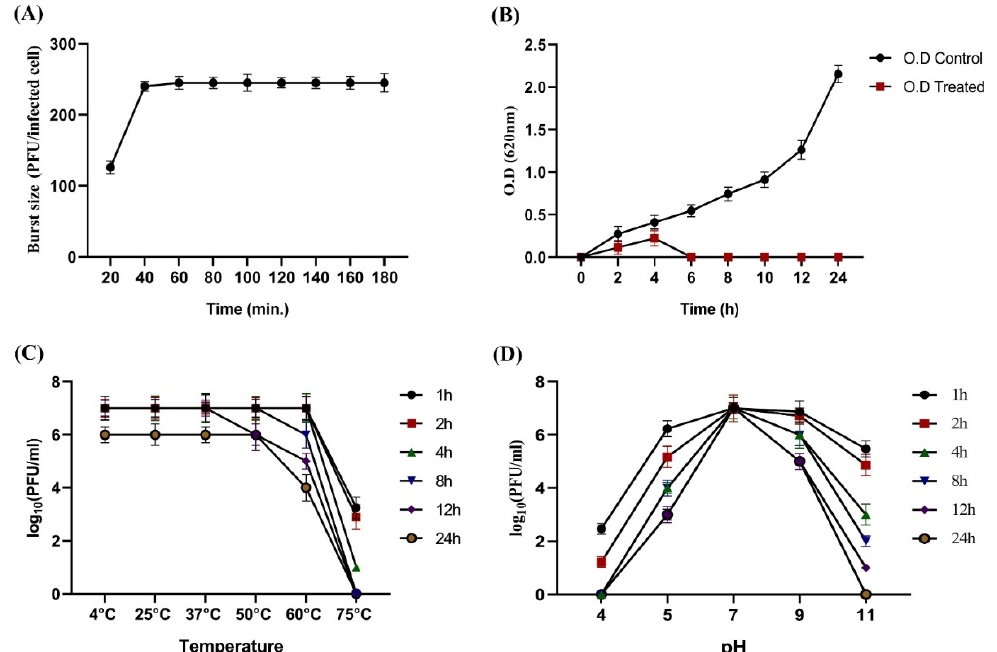
Figure 2. Single-step growth curve of the KPP-5 phage; values of the burst size and latency period were represented vertically and horizontally, respectively ( A ). Titers stability of the KPP-5 phage at different time periods ( B ) under different temperatures ( C ) and under different pH values ( D ).